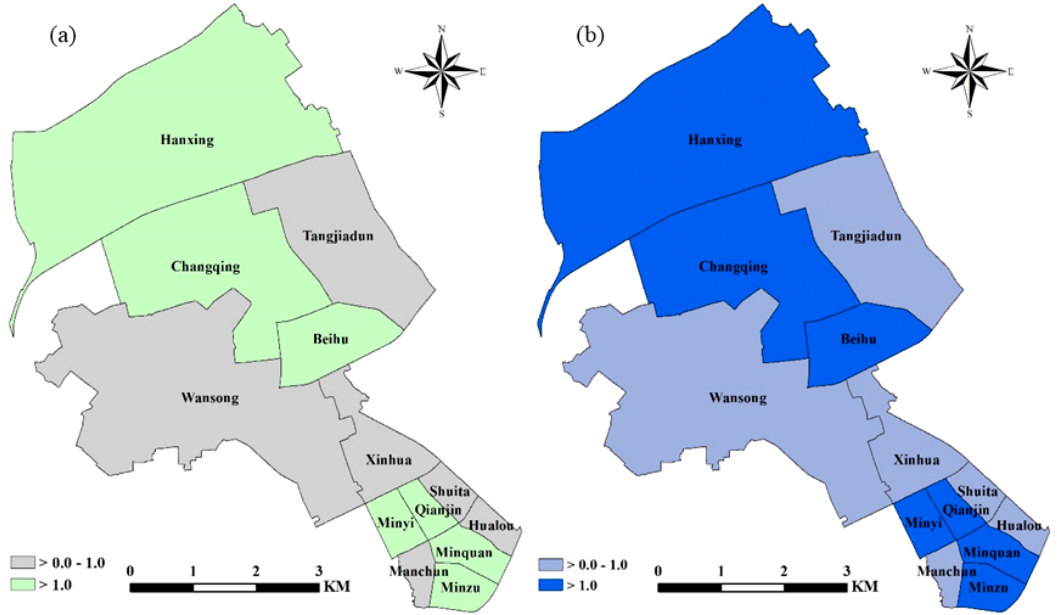
Figure 4. Burglary risks due to ( a ) unstructured contextual e ff ects and ( b ) spatially structured contextual e ff ects.